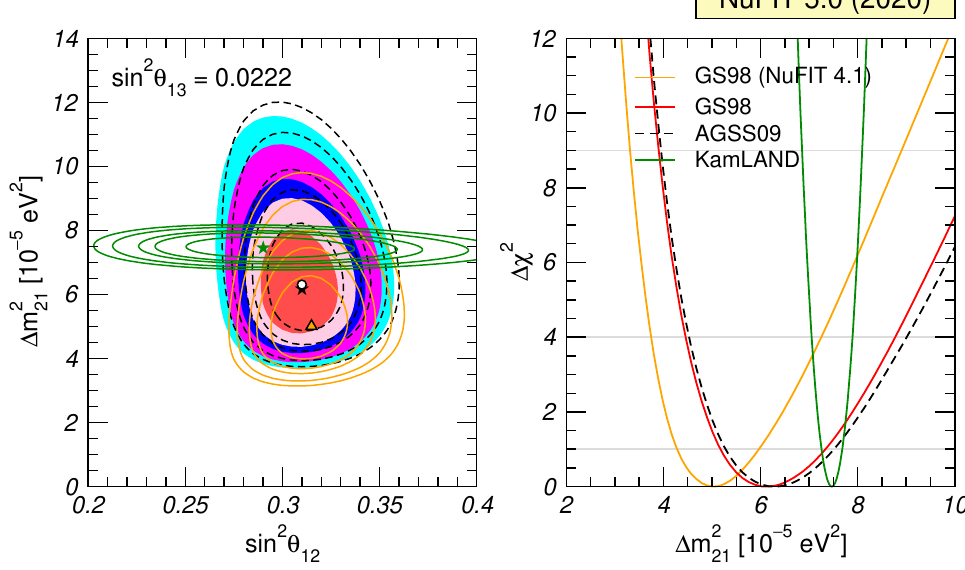
Figure 5 . Left: allowed parameter regions (at 1 (cid:27) , 90%, 2 (cid:27) , 99%, and 3 (cid:27) CL for 2 dof) from the combined analysis of solar data for GS98 model (full regions with best (cid:12)t marked by black star) and AGSS09 model (dashed void contours with best (cid:12)t marked by a white dot), and for the analysis of KamLAND data (solid green contours with best (cid:12)t marked by a green star) for (cid:12)xed sin 2 (cid:18) 13 = 0 : 0224 ( (cid:18) 13 = 8 : 6). We also show as orange contours the previous results of the global analysis for the GS98 model in ref. . [2]. Right: (cid:1) (cid:31) 2 dependence on (cid:1) m 2 analyses after marginalizing over (cid:18) 12